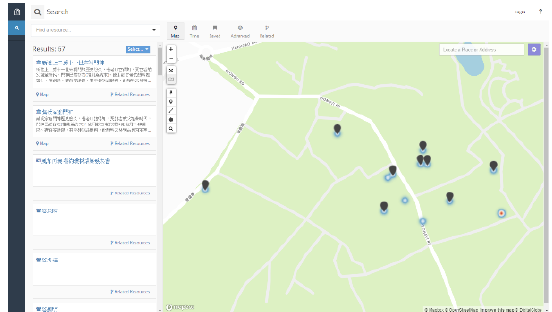
Figure 11. Map resource search function